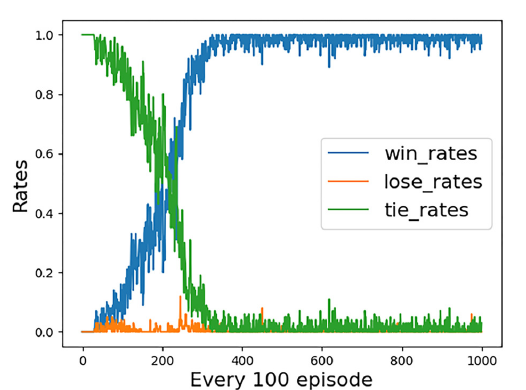
Figure 8. Our UCAV win rate change curve in case 1.